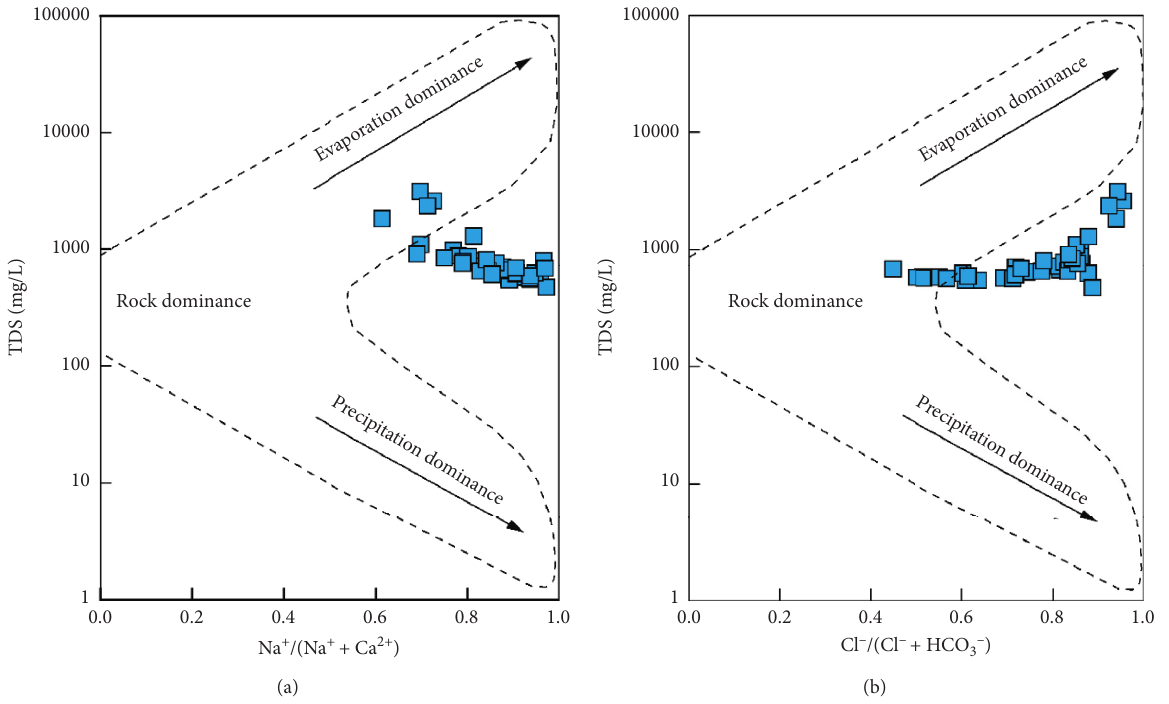
Figure 6: Gibbs diagrams demonstrating the natural mechanisms governing groundwater chemistry.